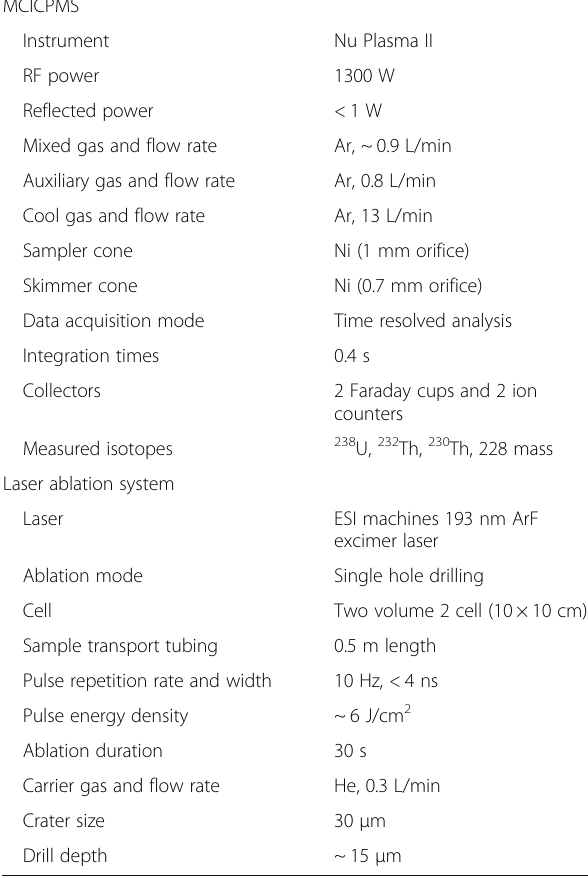
Table 1 LA-MCICPMS instrument and operational